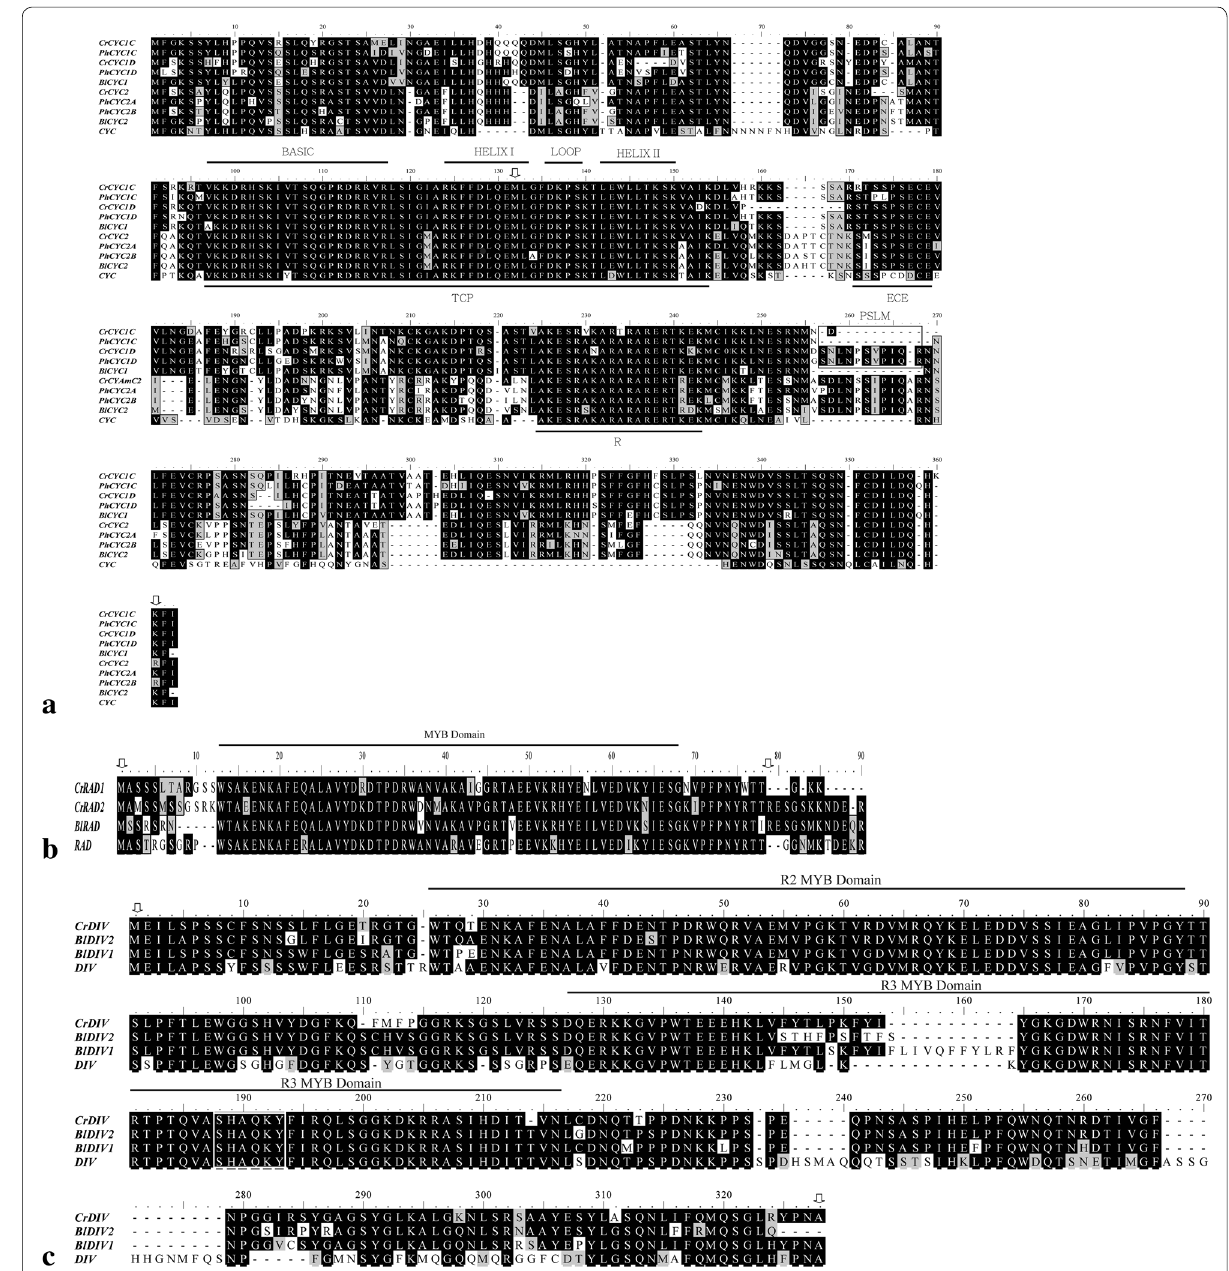
Fig. 3 Alignments of protein sequences of CrCYC , CrRAD and CrDIV genes with homologs from Antirrhinum majus ( CYC , RAD and DIV ) and Bournea leiophylla ( BlCYC1 , BlCYC2 , BlRAD , BlDIV1 and BlDIV2 ). a Alignmentes of CYC homologs. TCP, ECE and R domain are outlined. Identical amino acids are in black and similar amino acids are in gray. b Alignments of RAD homologs. MYB domain are outlined. c Alignments of DIV homologs. Two MYB domains (R2 and R3) are outlined. A highly conserved SHAQKY motif in R3 MYB domain is identified and labelled in white box. Arrows indicate sequence region used in phylogeny analysis. Sequence region used in phylogenetic analysis coving almost all important domains in all three gene dataset except for PlDIV in DIV